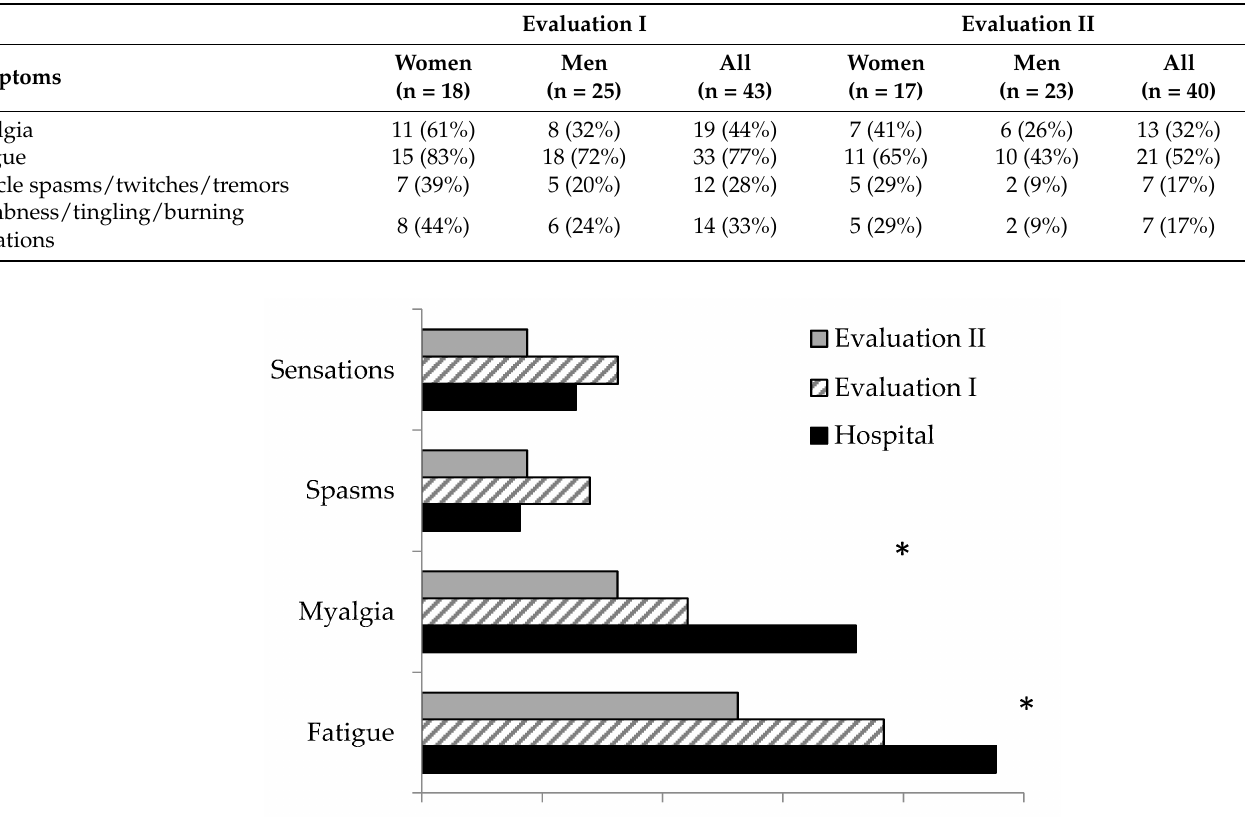
Table 2. Frequency of the symptoms reported by 43 patients at the first evaluation, and 40 patients at the second evaluation.